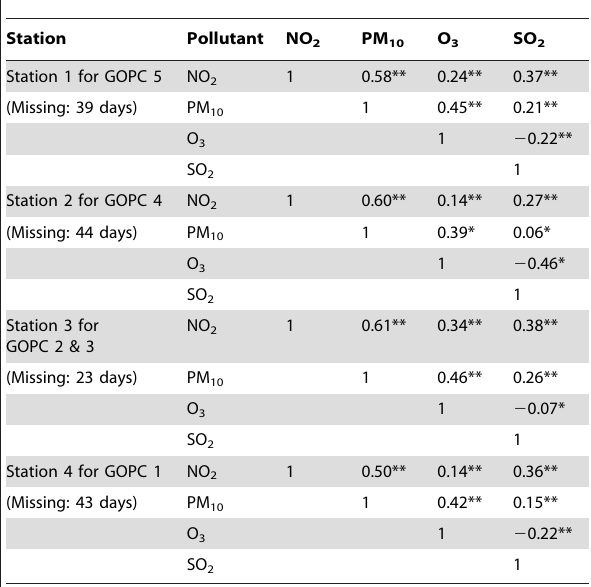
Table 3. Correlation between pollutants by monitoring